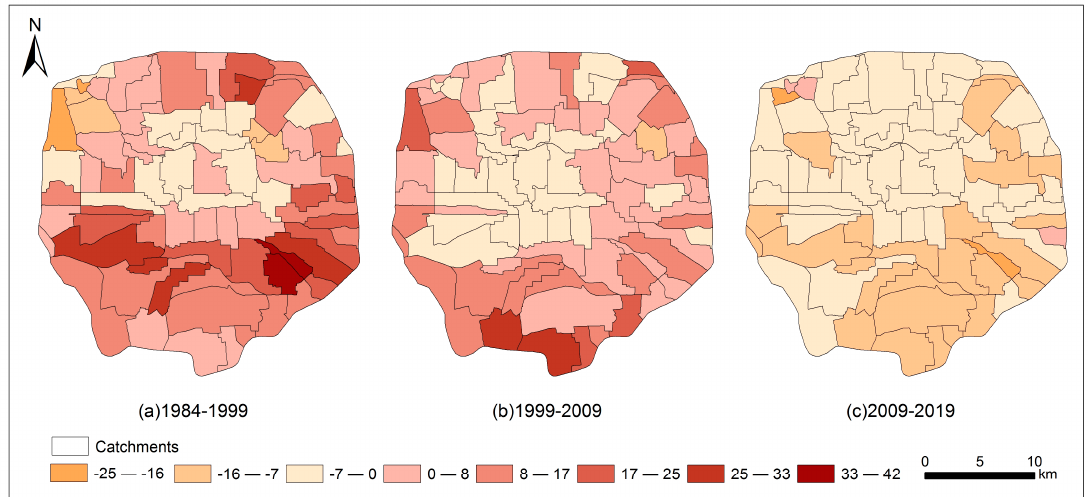
Figure 7. Variation in surface runoff over the periods of ( a ) 1984–1999, ( b ) 1999–2009, and ( c ) 2009–2019 under the rainfall return period of 100a.